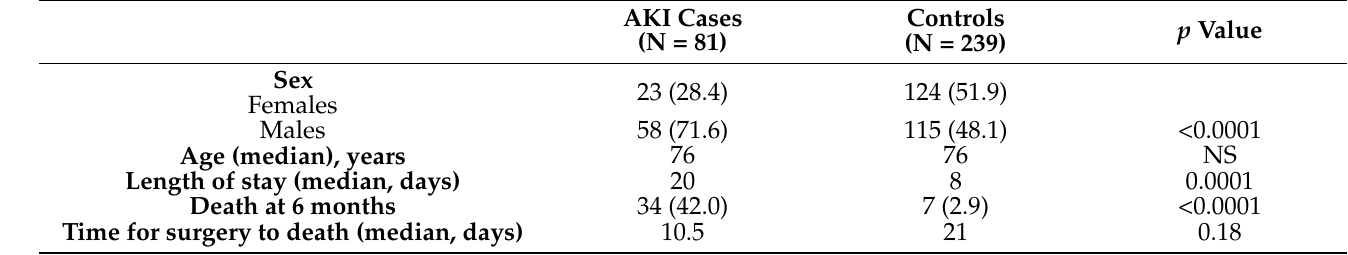
Table 1. Baseline characteristics and outcomes among 81 cases with AKI and 239